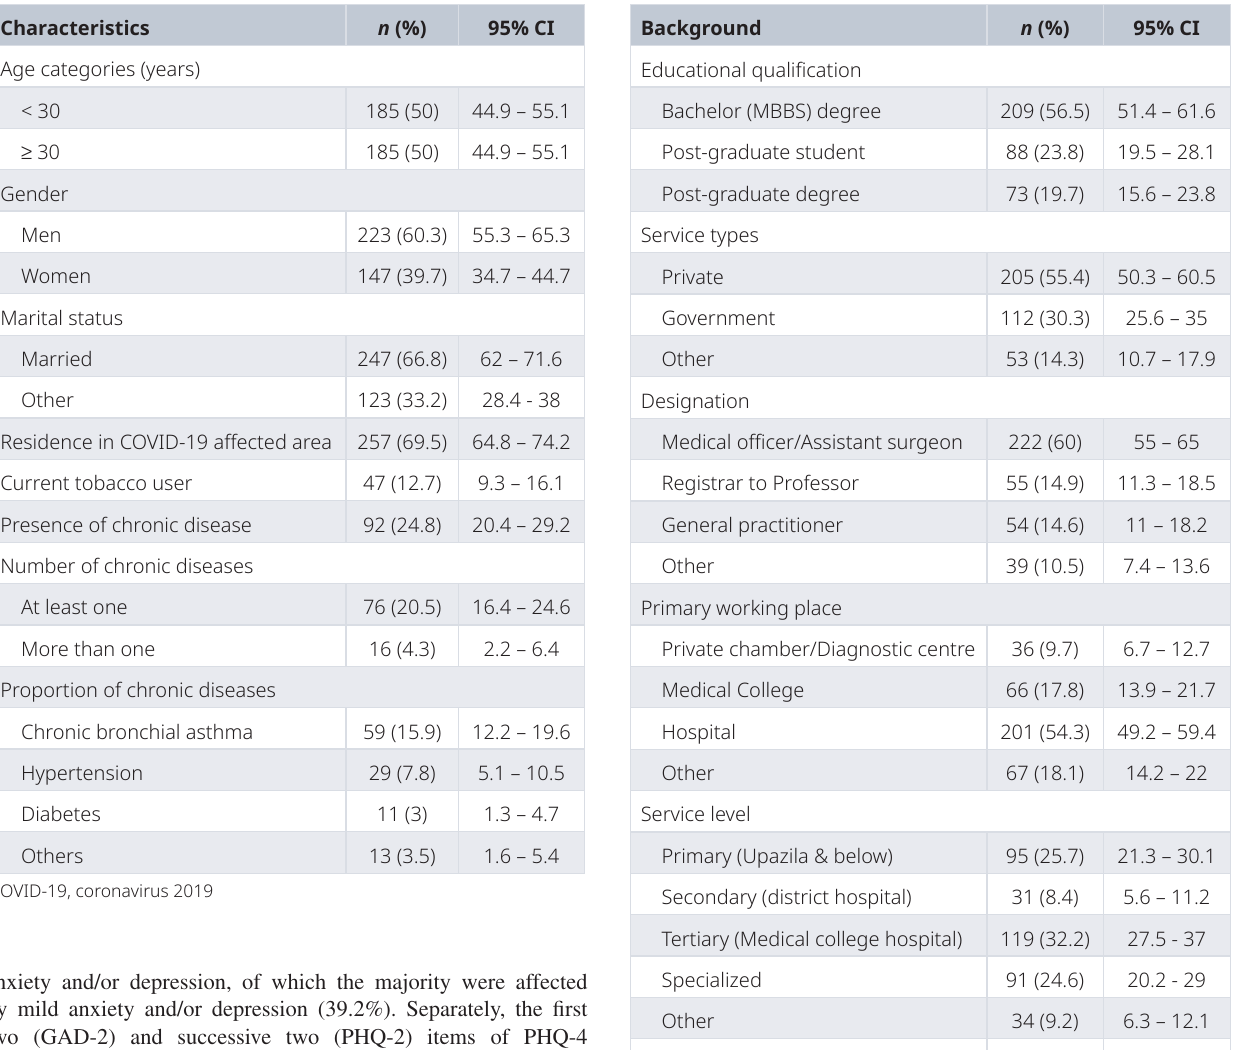
Table 1. Demographic and health-related characteristics of frontline doctors of Bangladesh (n= 370).